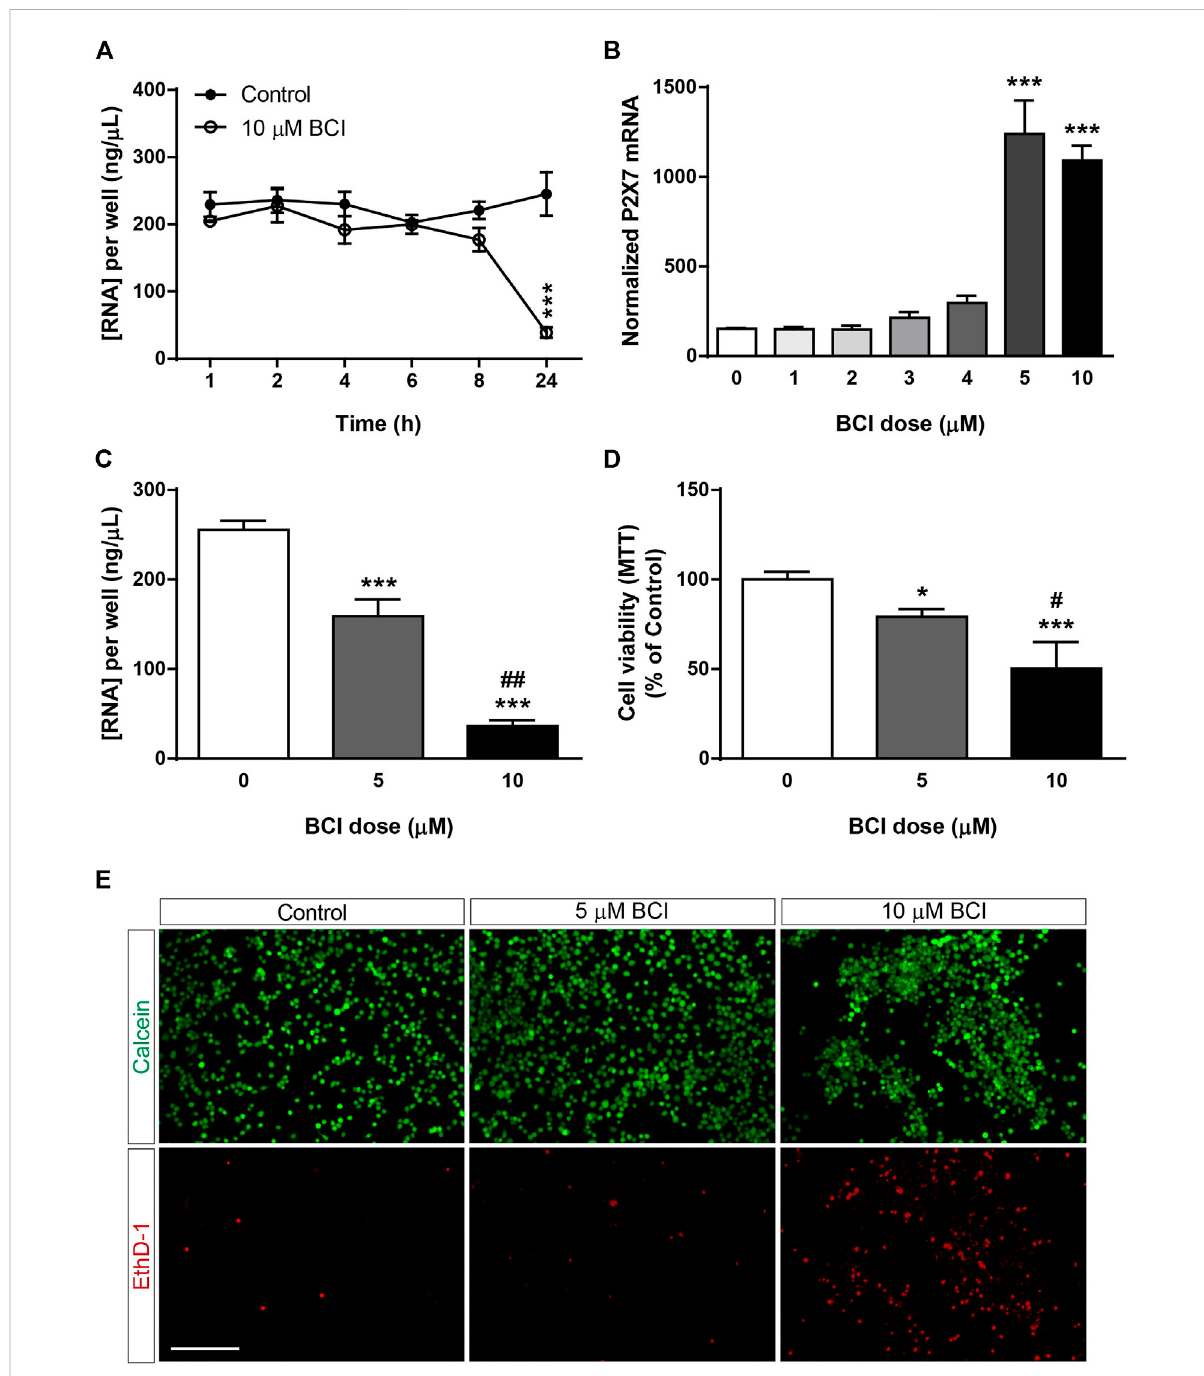
FIGURE 2 Dose-dependent cytotoxicity of BCI in neuroblastoma cells. (A) N2a cells were incubated in SFM for 1, 2, 4, 6, 8 or 24 h in presence of BCI (10 μ M) or in its absence (control). Total RNA was then extracted from the cells and quanti fi ed. The results are the mean ± SEM of fi ve independent experiments performed in triplicate. *** p ≤ .001 vs. control (B) N2a cells were incubated for 24 h in SFM in the presence or absence of increasing concentrations of BCI (ranging from 1 to 10 μ M). Total RNA was extracted from the cells, and 1 µg was reversed transcribed and quanti fi ed by qPCR, using GADPH as a housekeeping gene and normalizing the P2RX7 expressionto that in untreated cells (dose = 0, set as 100%). The results are themean±SEMoffourindependentexperimentsperformedintriplicate.*** p ≤ .001vs.untreatedcells. (C) N2acellswereculturedfor24 hinSFMin the presence or absence of either 5 μ M or 10 μ M BCI. Total RNA was extracted and quanti fi ed, showing the results as the mean ± SEM of six independentexperimentsperformedintriplicate.*** p ≤ .001vs.control; ## p ≤ .01vs.5 μ MBCI. (D) MTTassayofN2acellsculturedfor24 hinSFMin thepresenceorabsenceofeither5 μ Mor10 μ MBCI.Thevalueswerenormalizedtothoseobtainedfromuntreatedcells(dose=0,setas100%).The resultsarethemean±SEMoffourindependentexperimentsperformedintriplicate.* p ≤ .05,*** p ≤ .001vs.untreatedcells; ## p ≤ .01vs.5 μ MBCI. (E) LIVE/DEAD ® Viability/Cytotoxicity Assay of N2a cells cultured for 24 h in SFM in the presence or absence of either 5 μ M or 10 μ M BCI. Viable cells were loaded with calcein (green) whereas the nuclei of dead cells are stained with EthD-1 (red). Scale bar = 200 μ